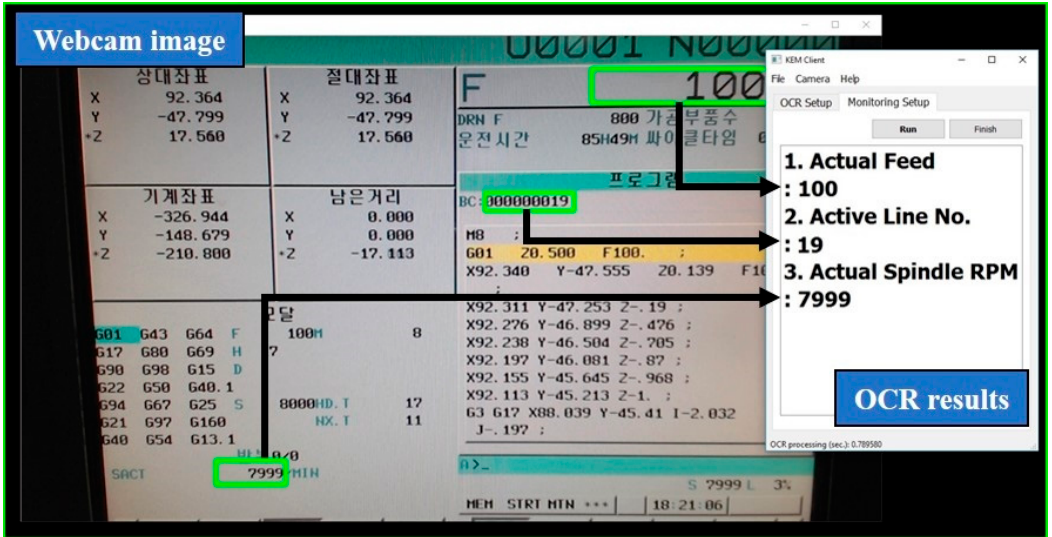
Figure 9. Display of OCR process in the KEM client; green rectangular boundaries mean the ROIs.